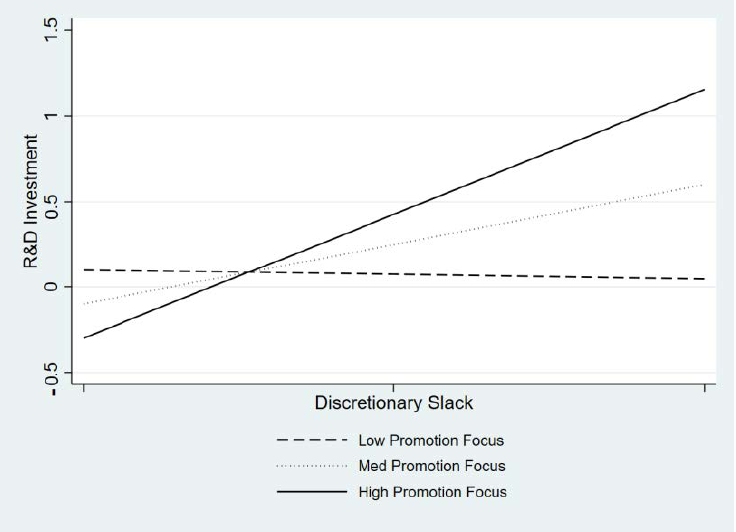
Figure 1. Effects of discretionary slack on R&D investment at different levels of CEO promotion focus.